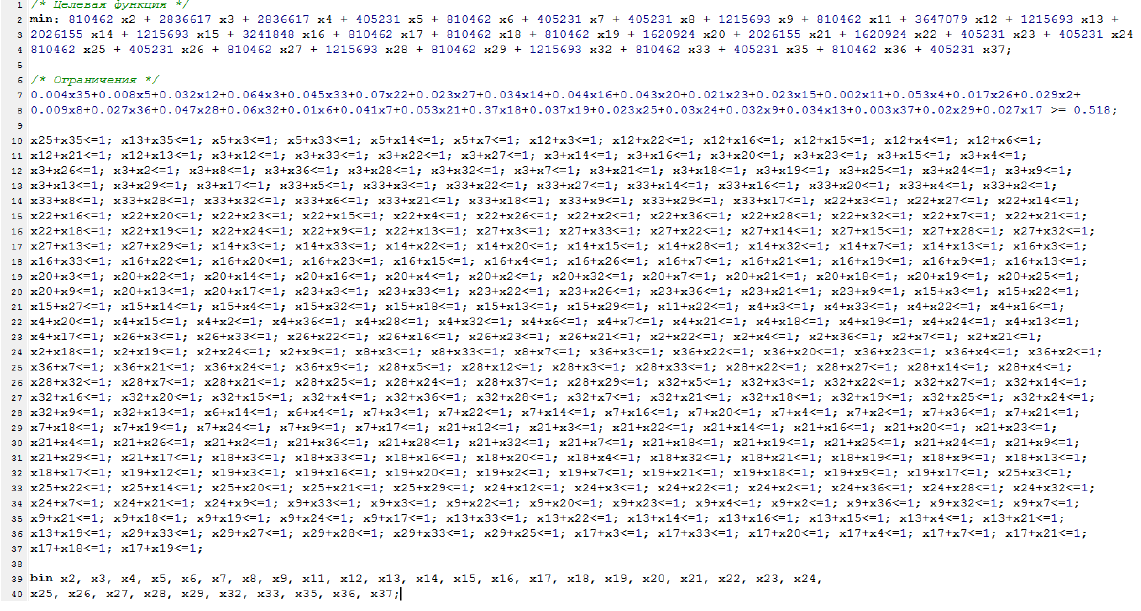
Figure 6: The example of mathematical optimization model of RFID devices’ placement at railway transport node comprising 37 industrial railway